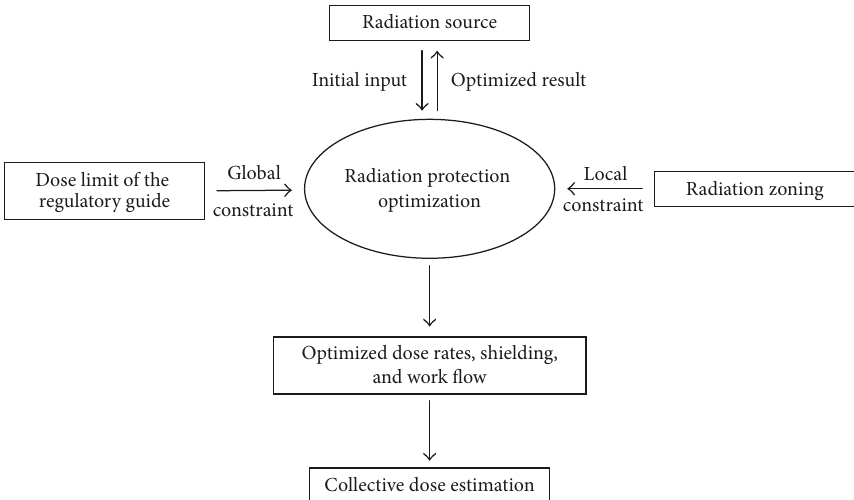
Figure 1: Framework of the radiation protection optimization in the HTR-PM